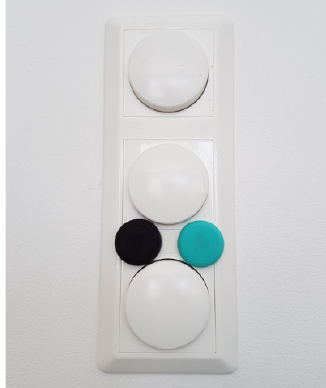
Figure 3 . Buttons placed next to traditional switches in a participant’s home.